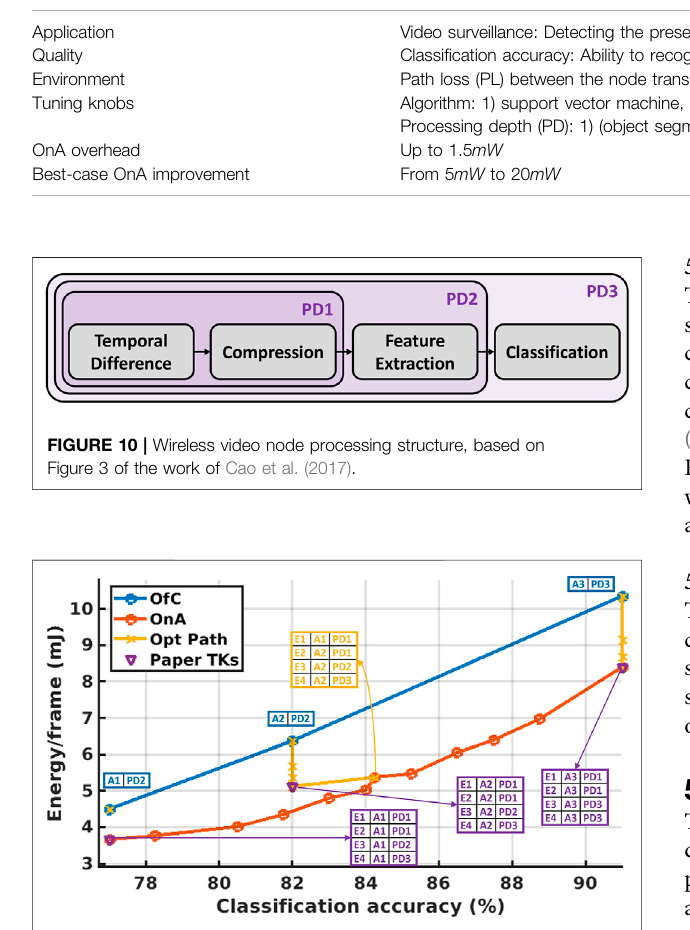
FIGURE11 | Wireless video node:Ofc vs. best-case OnA power-quality Pareto fronts, with quality being the detection accuracy of people in the camera and power expressed in